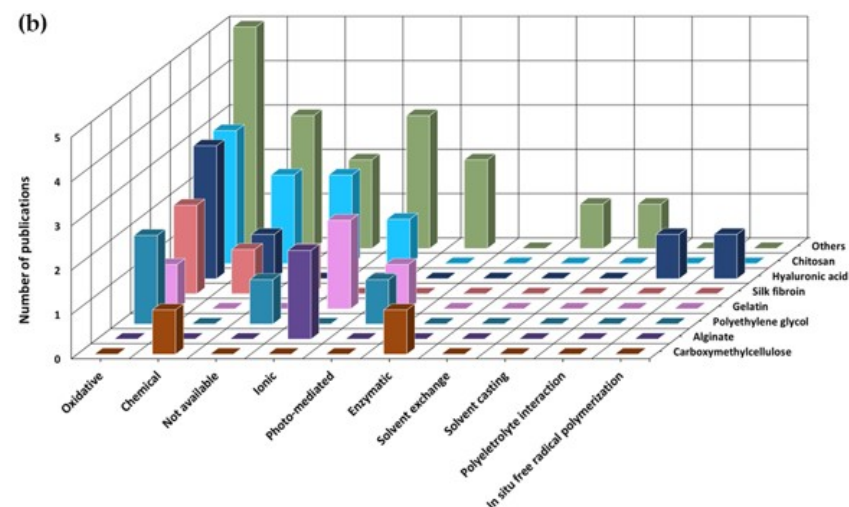
Figure 5. Graphical illustrations of the selected manuscripts. Graphical illustration of the final group of selected manuscripts per ( a ) coupling chemistry for catechol conjugation and ( b ) crosslinking mechanism.